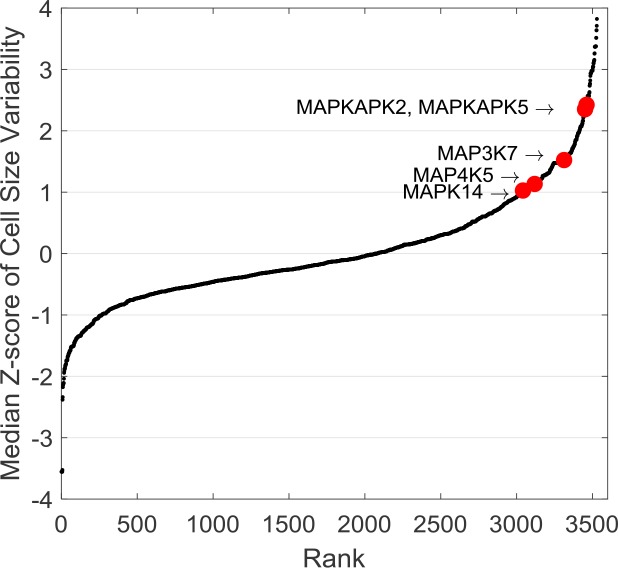
The average z-score of cell size variability corresponding to each of the different target proteins.To estimate the cell size variability that results from inhibition of a specific protein, z-scores were averaged from all screen compounds targeting that protein. An average cell size variability was calculated for each of the target proteins and ranked from small to large. Components of the p38 MAPK pathway (highlighted in red) are ranked among the top proteins with increased z-scores in cell size variability.